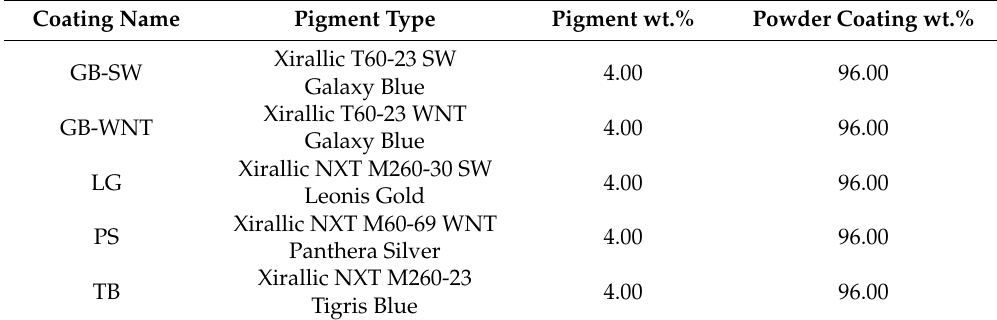
Table 1. Nomenclature of the samples with the component